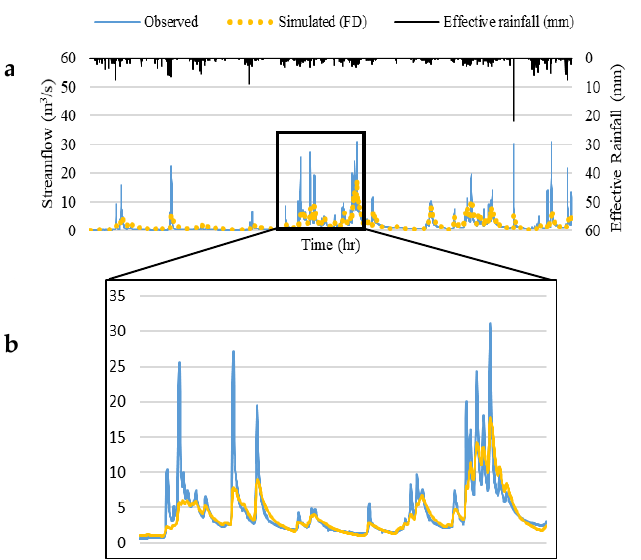
Figure 5. ( a ) Validation of the calibrated FD model using the single-objective (SO) approach; ( b ) zoomed in for a clear view.